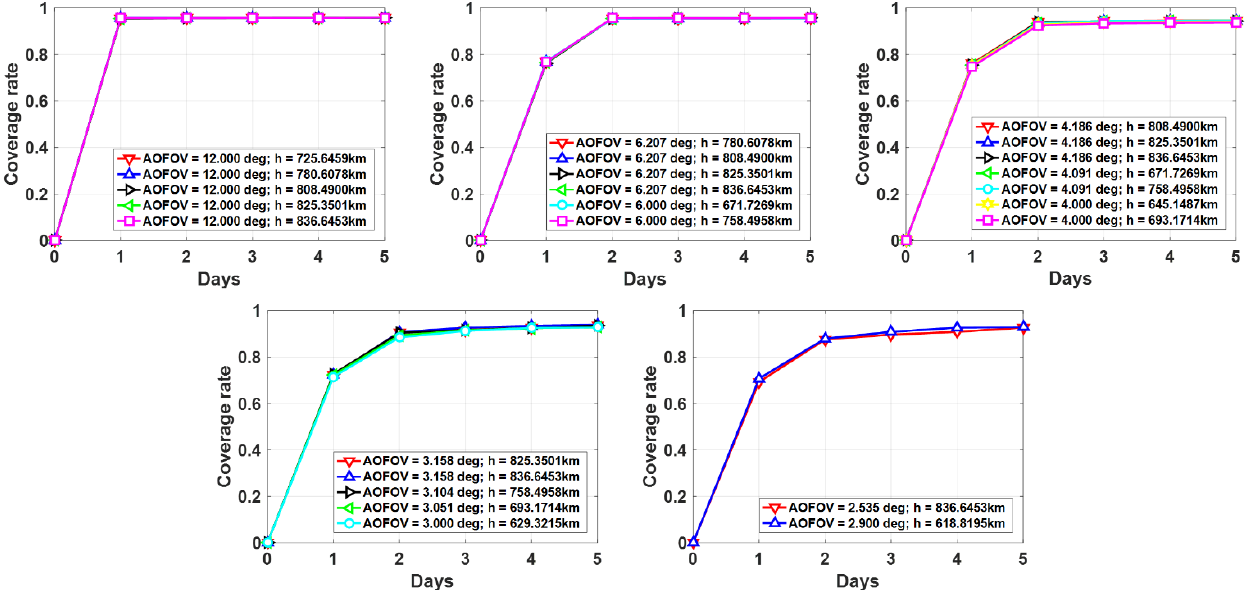
Figure 7. Simulation results of the minimum FOV in the along-orbit direction that meets the require- ments when the revisit period of the satellite ranges from 1 day to 5 days.